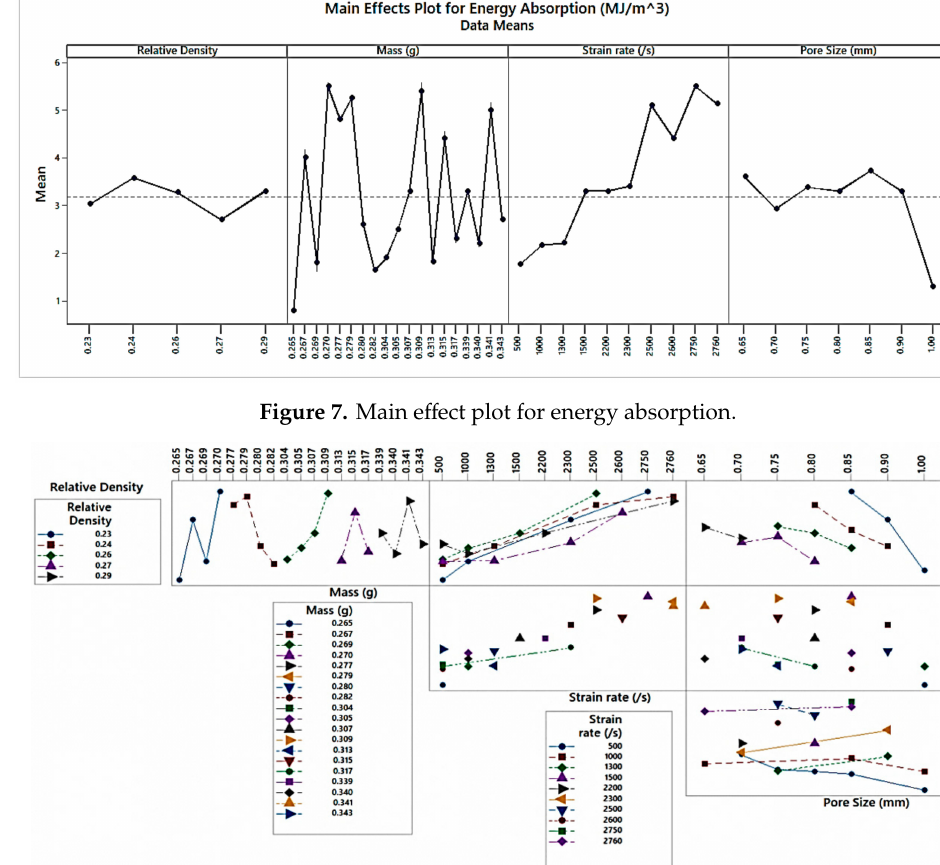
Figure 8. Interaction plot for energy absorption from the ANOVA